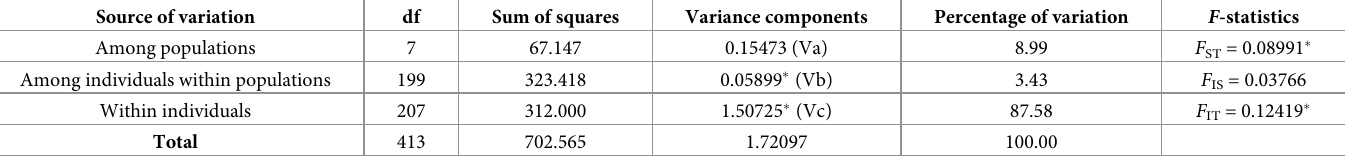
Table 3. Results from AMOVA analysis of only Zulu